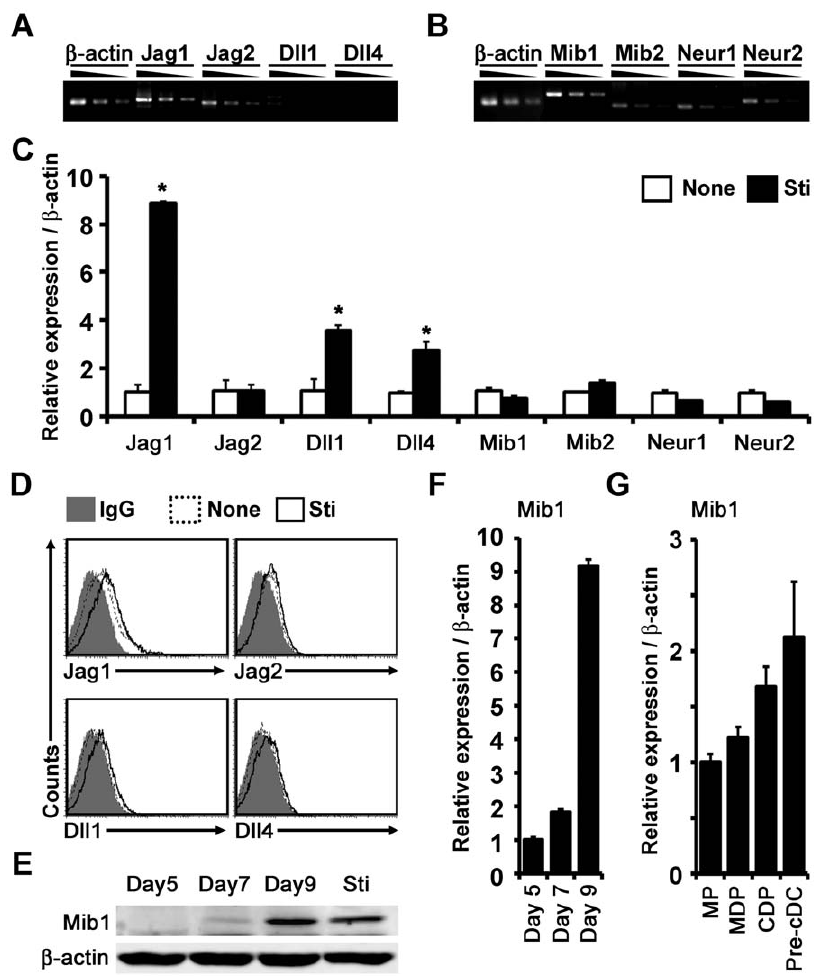
Figure 1. Expression of ligands and E3 ligases for Notch signaling in DCs. A and B , Semi-quantitative RT-PCR analyses of Notch ligands ( A ) and E3 ubiquitin ligases ( B ) in BM-derived DCs prior to LPS stimulation. Serial 2-fold dilutions of PCR products were electrophoresed in agarose gel C , Quantitative real-time RT-PCR analysis of ligands and E3 ligases in DCs before ( None ) and after 24 h of LPS stimulation ( Sti ). The results are representative of more than five independent experiments. D , Flow cytometry analysis for Notch ligands in DCs. IgG, Armenian hamster IgG isotype control; None, DCs before LPS stimulation; Sti, DCs after LPS stimulation. Results are representative of three independent experiments. E , Western blot analysis of Mib1 in BM culture with rGM-CSF on days 5, 7, and 9, and 24 h after LPS treatment on day9 ( Sti ). F , Quantitative real-time RT-PCR analysis of Mib1 in BM culture with rGM-CSF on days 5, 7, and 9. G , Quantitative real-time RT-PCR analysis of Mib1 in the BM precursors of classical spleen DC. MP, myeloid progenitor; MDP, macrophage and DC precursor; CDP, common DC precursor; pre-cDC, committed precursors of classical spleen DC. Results are representative of three independent experiments. Data represent mean 6 SD; *, P , 0.05.